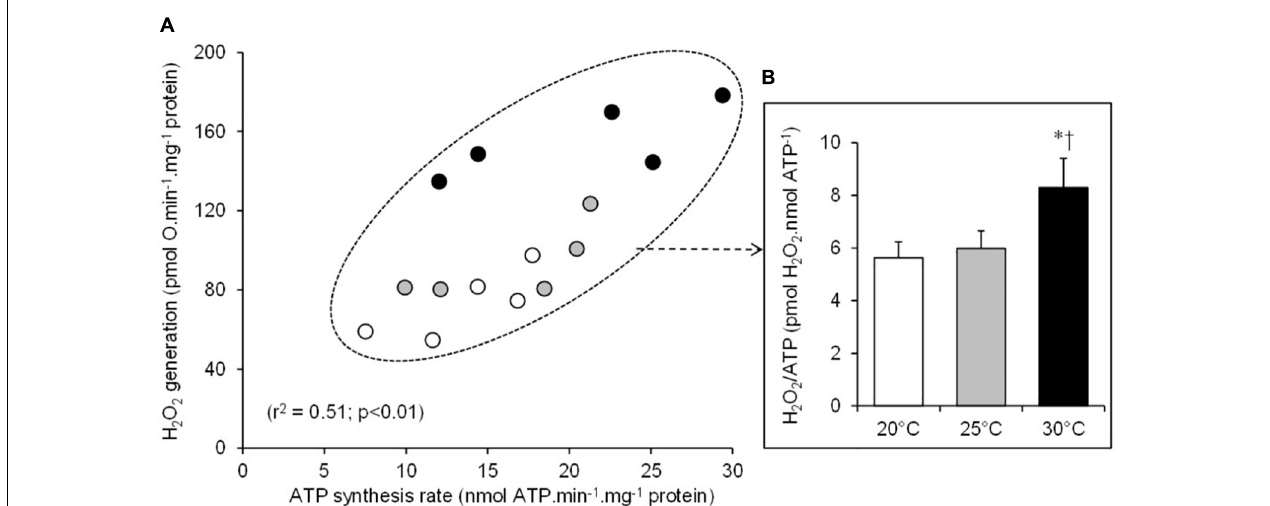
FIGURE 4 | Relationship between the individual H 2 O 2 production and the mitochondrial ATP synthesis rates (A) . The individual values show five independent mitochondrial preparations from the liver of toad measured at 20 ◦ C (white circles), at 25 ◦ C (gray circles), and at 30 ◦ C (black circles). (B) The oxidative cost of ATP production (% H 2 O 2 /ATP ratio) calculated at 20 ◦ C (white bars), at 25 ◦ C (gray bars), and at 30 ◦ C (black bars). The values are means ± SEM for N = 5 independent mitochondrial preparations. * and † mean significantly different from 20 and 25 ◦ C, respectively ( p < 0.05).